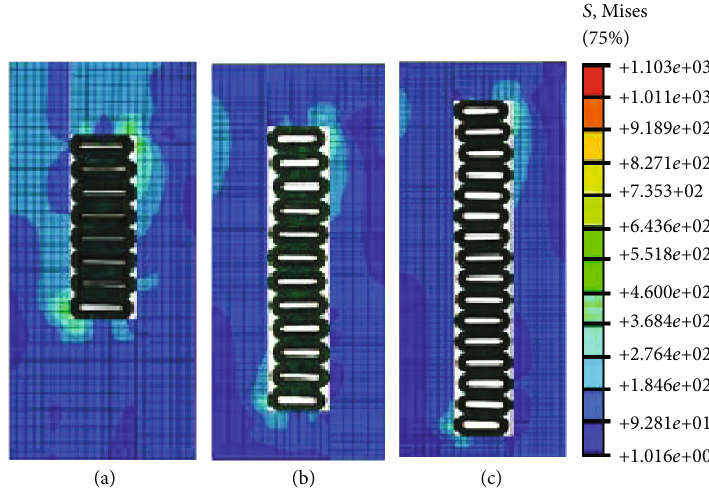
Figure 13: Compression of the metal tube stacks under collision (distribution cloud picture of equivalent